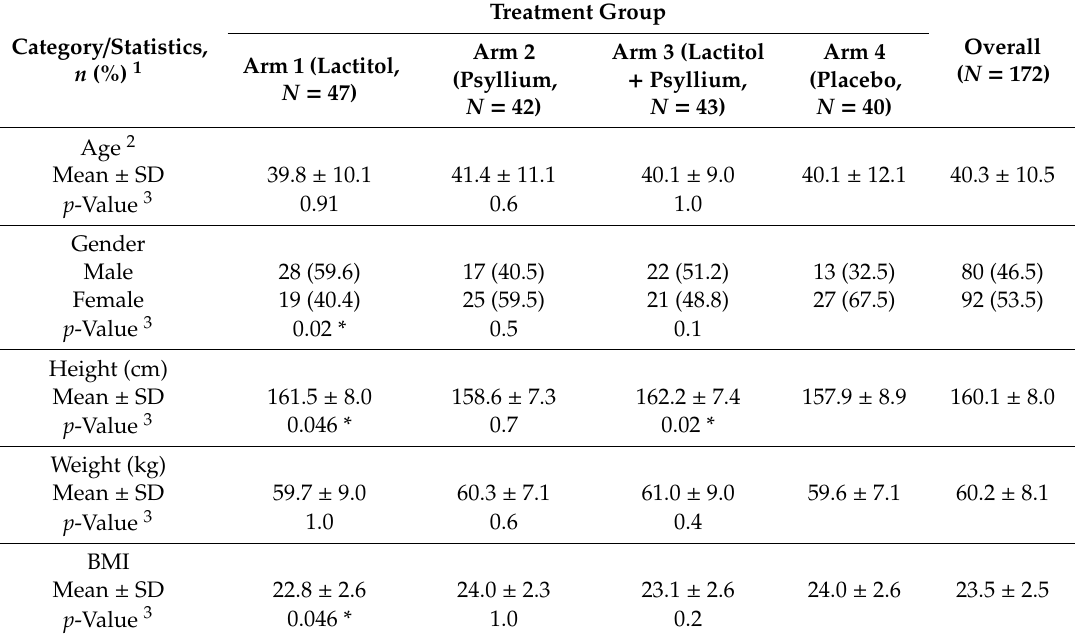
Table 1. Summary of Volunteer Demographics at Screening Visit for ITT Population ( N =